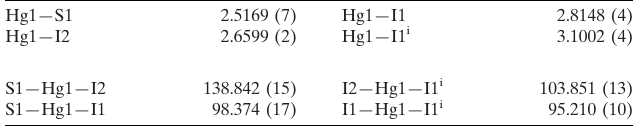
Selected geometric parameters (A˚ , (cid:2)